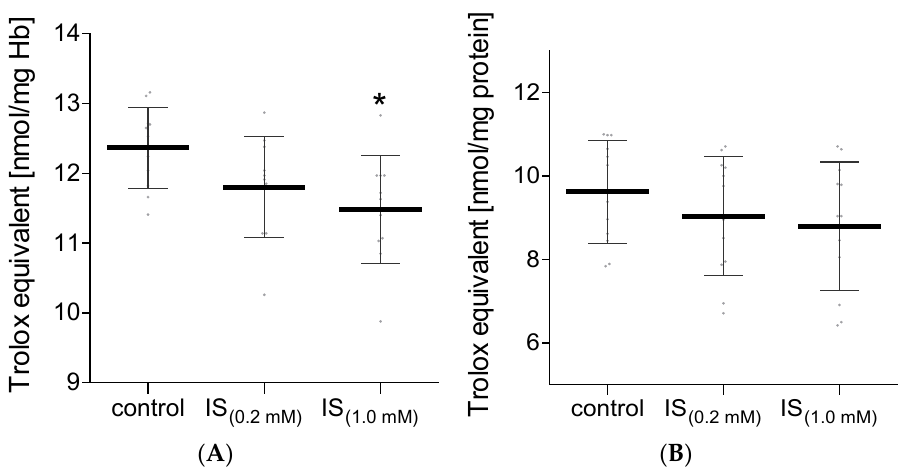
Figure 6. The levels of NEAC in hemolysate ( A ) and plasma ( B ) after incubation with IS, measured using TPTZ. Data are expressed as mean ± standard deviation, n = 12, * p < 0.05—IS (1.0 mM) vs. control. Gray spots: values of single results.